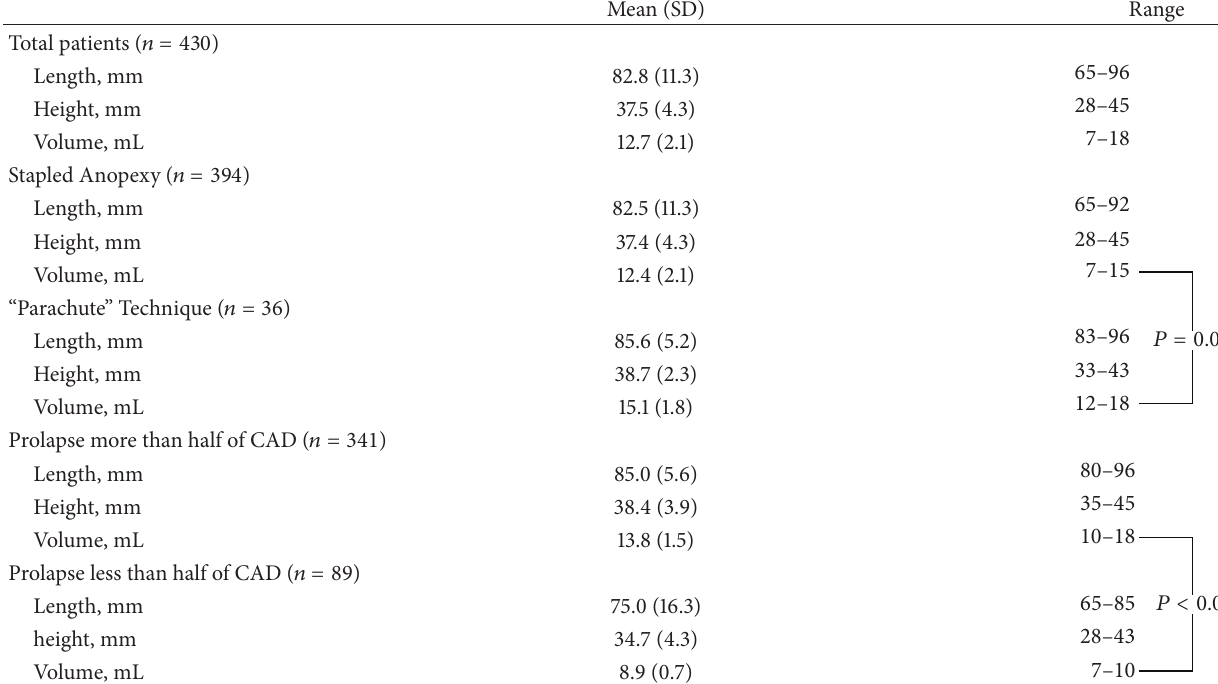
Table 3: Specimen measures stratified by type of prolapsectomy (traditional Longo’s procedure or “Parachute” Technique) and extent of rectal